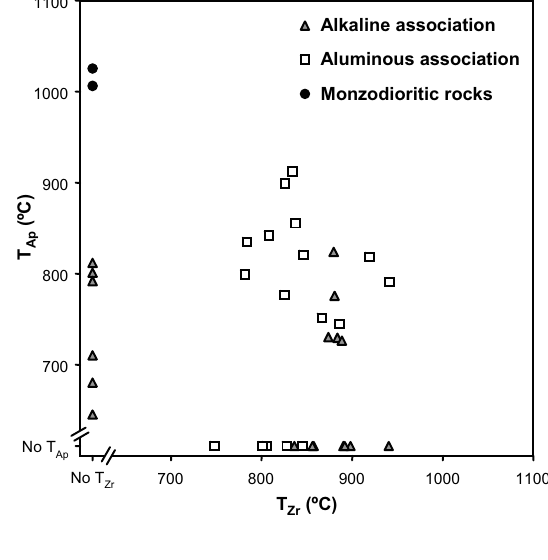
Fig. 7 – Plot of calculated apatite vs zircon saturation temperatures (T AP , T Zr ) for granites and syenites of the aluminous and alkaline associations related monzodioritic rocks from the Serra da Graciosa region. Samplesoutsidetheidealrangesofcompositionortemperature are plotted as No T AP or No T Zr